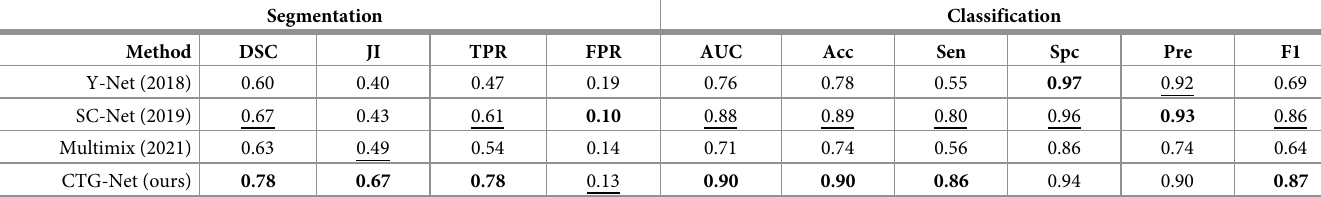
Table 4. Segmentation and classification performance compared with state-of-the-art multi-task learning methods on the THH dataset. Segmentation